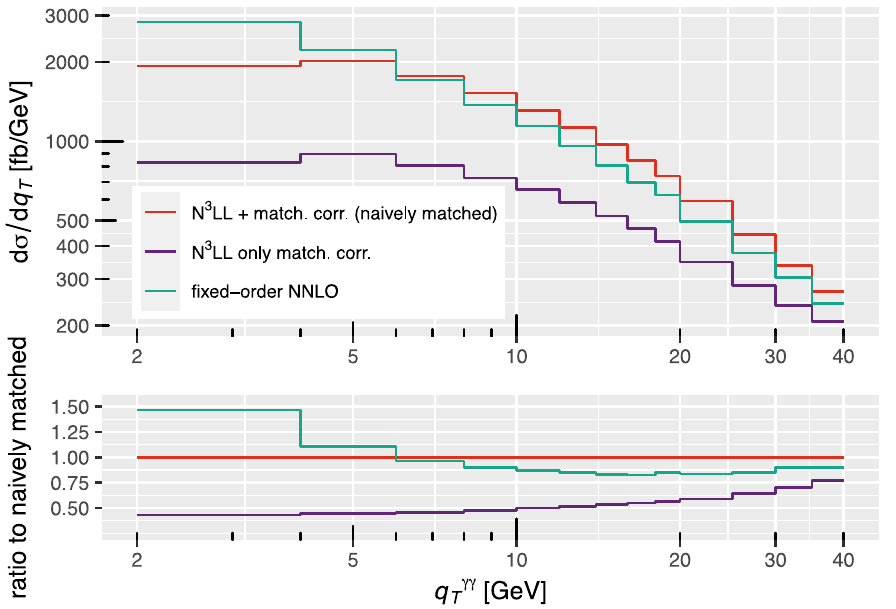
Figure 16. Comparison of the naively matched result at N 3 LL+NNLO , the matching corrections and the fixed-order result for diphoton production with the cuts used by ATLAS [131], see table 4. The second panel displays the ratio to the naively matched result to demonstrate the large matching corrections even at small q T